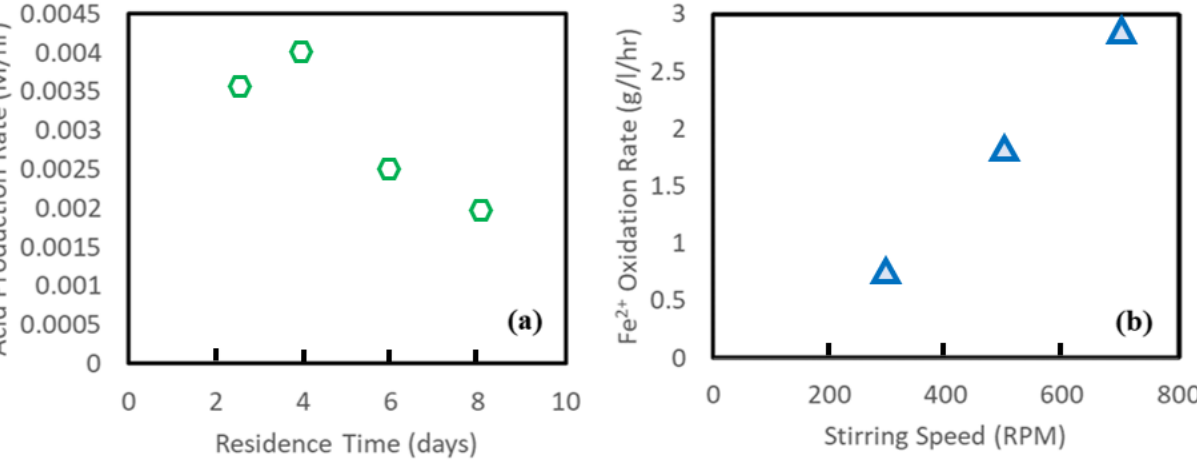
Figure 7. ( a ) Comparison of residence time and acid production rate. ( b ) Initial comparison of stirring speed and ferrous ion oxidation rate.